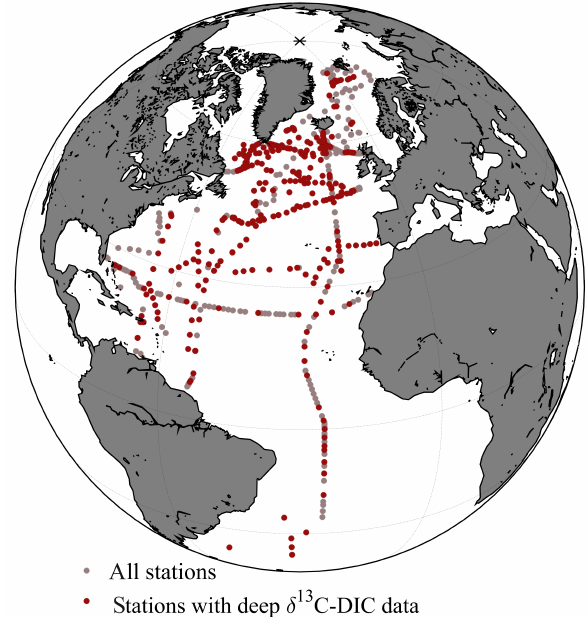
Figure 1. Map of all stations with δ 13 C-DIC data used in this dataset. Data from deeper than 1500m were available only for the stations in dark red, so only these stations were used for the crossover